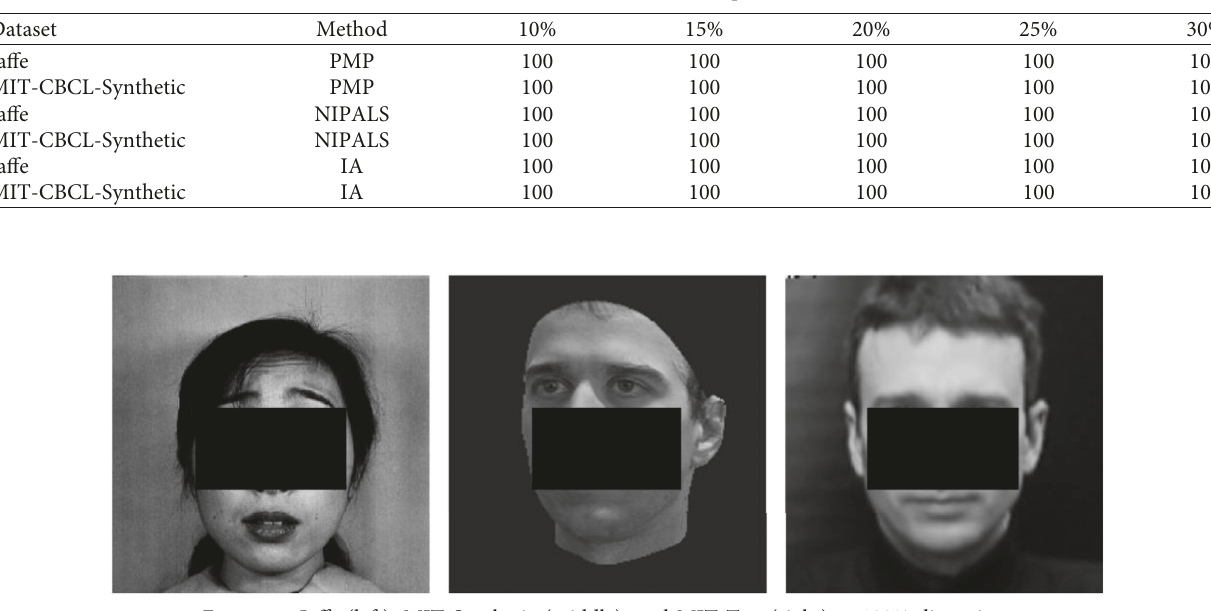
Table 3: Model assessment with imputation.